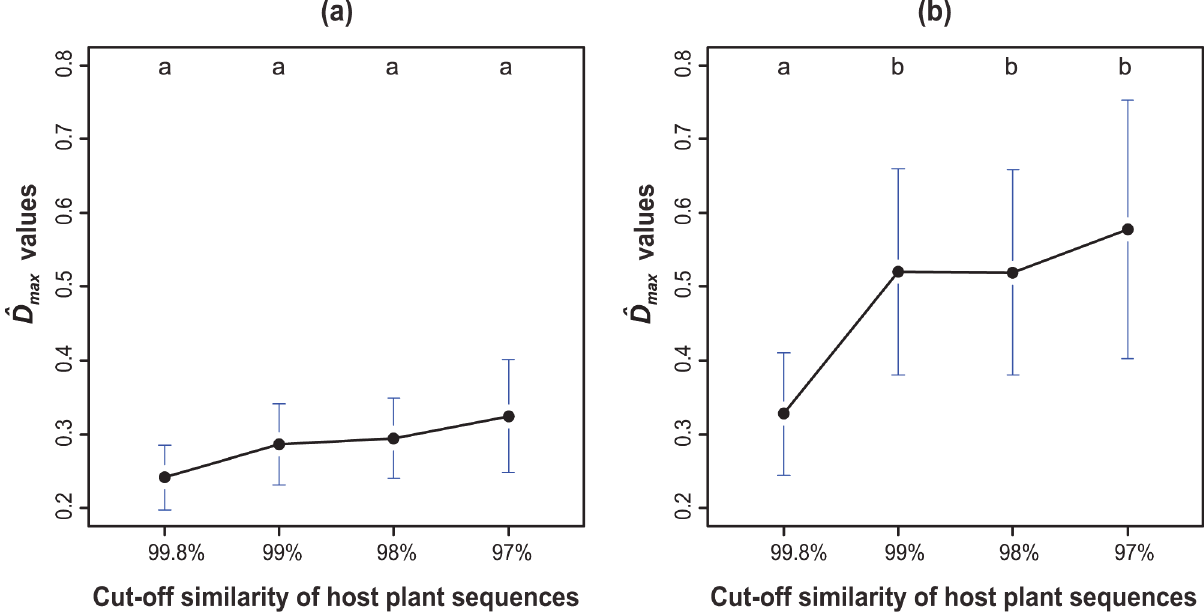
Fig 3. D ^ max values (index of degrees of apparent host preference at the particular taxonomic rank of host plants) within the respective OTUs of (a) Ascomycota and (b) putative ectomycorrhizal Basidiomycota. D ^ These values were calculated separately for the datasets based on the different cut- max off similarities of host plant sequences (97%, 98%, 99%, and 99.8%). The values of D ^ correspond to those of Fig 2 and Fig 3, respectively. Different letters indicate a statistically significant difference between cut-off levels of host plant sequences ( α = 0.05, using a Holm correction).